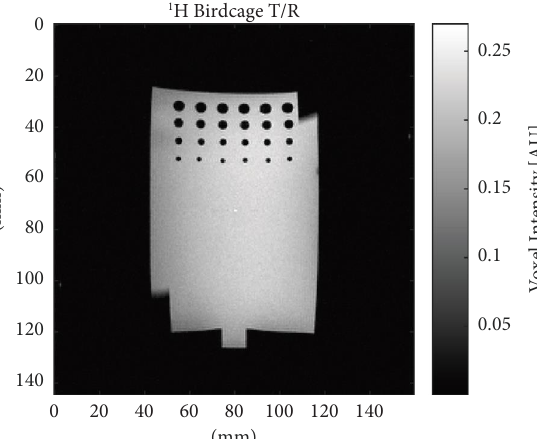
Figure 7: Double-tuned birdcage T/R image showing feld homogeneity with a receive loop present but unused in the bottom left corner.